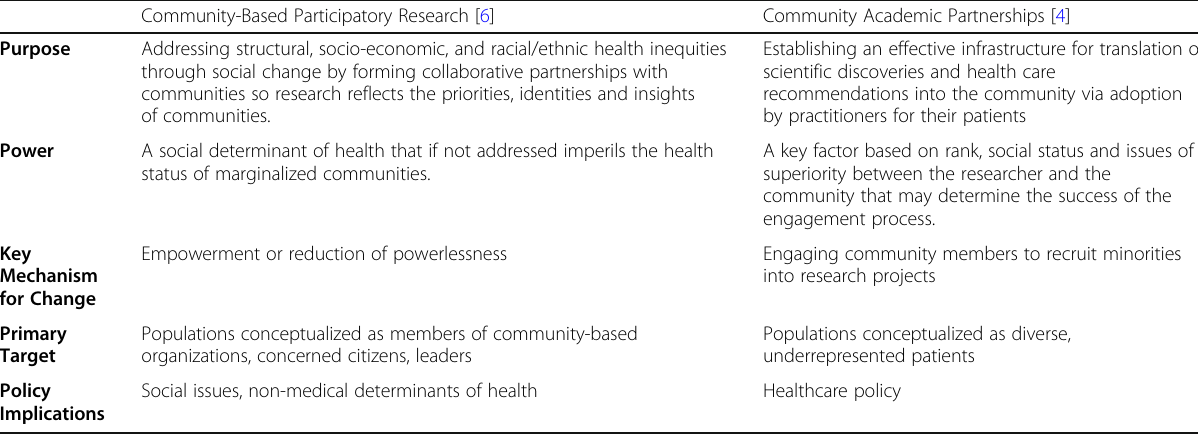
Table 1 Characteristics of community-based participatory research versus community academic partnerships Community-Based Participatory Research